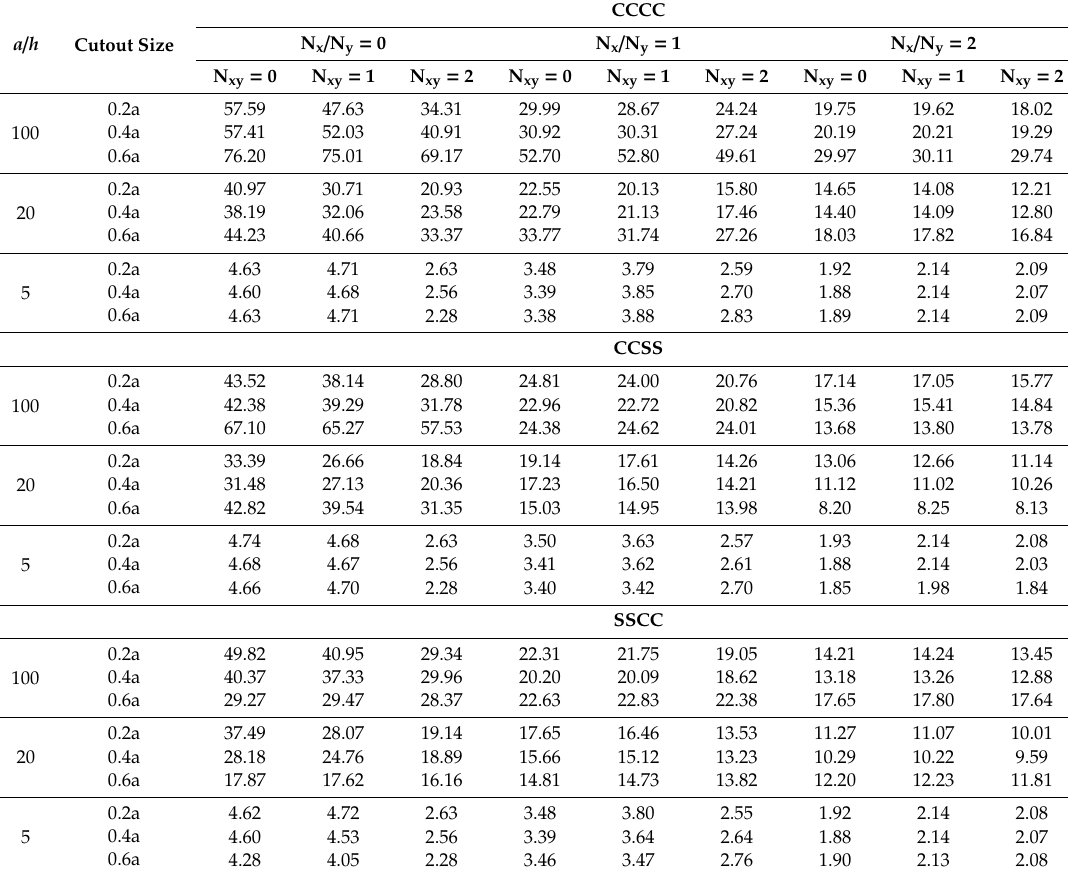
Table 11. Non-dimensional buckling load λ = ( λ b 2 /E 2 h 3 ) for a bi-axial buckling of a composite plate having lamination scheme C and central square